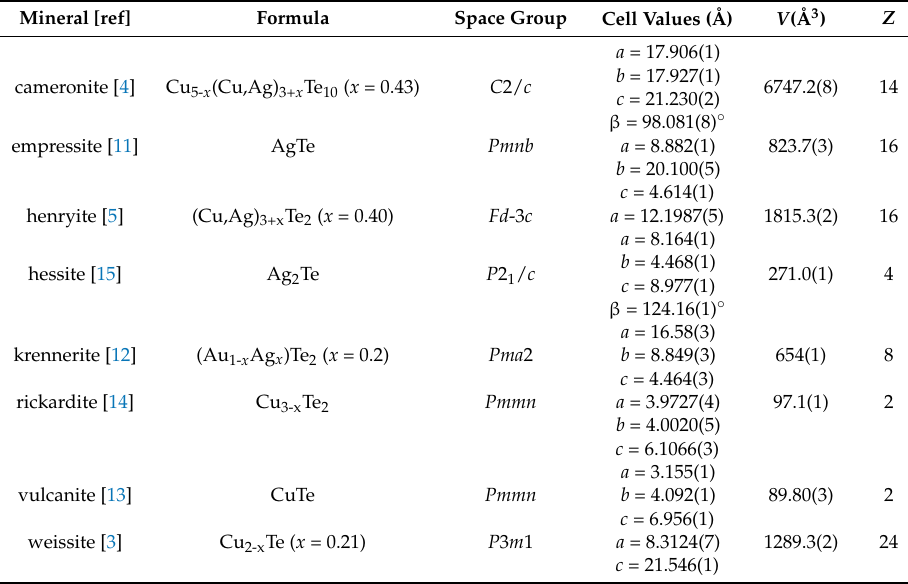
Table 8. Minerals belonging to the Cu-Ag-Te